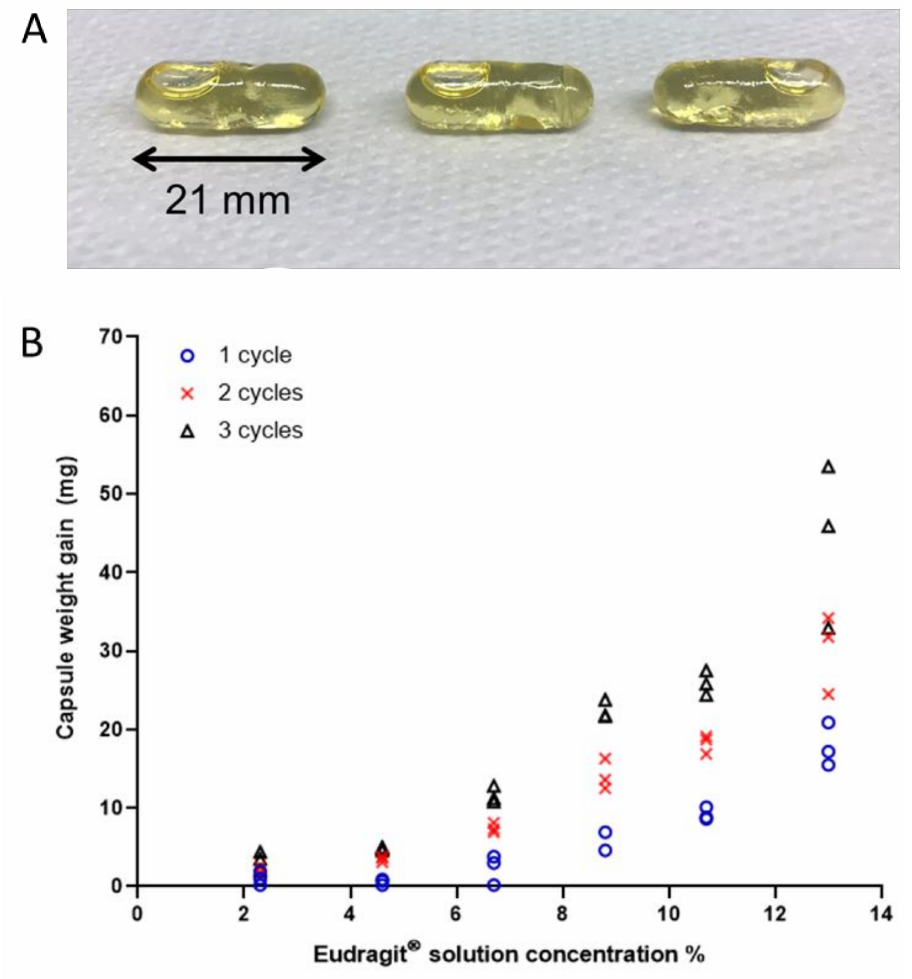
Figure 1. ( A ) A representative example of HPMC capsules filled with olive oil and coated with Eudragit ® S 100. The capsule measures 21 mm length by 7 mm diameter. ( B ) Capsule weight gain measured in triplicate at 24 h after one, two and three dipping (coating) cycles for different concentrations of Eudragit ® S 100